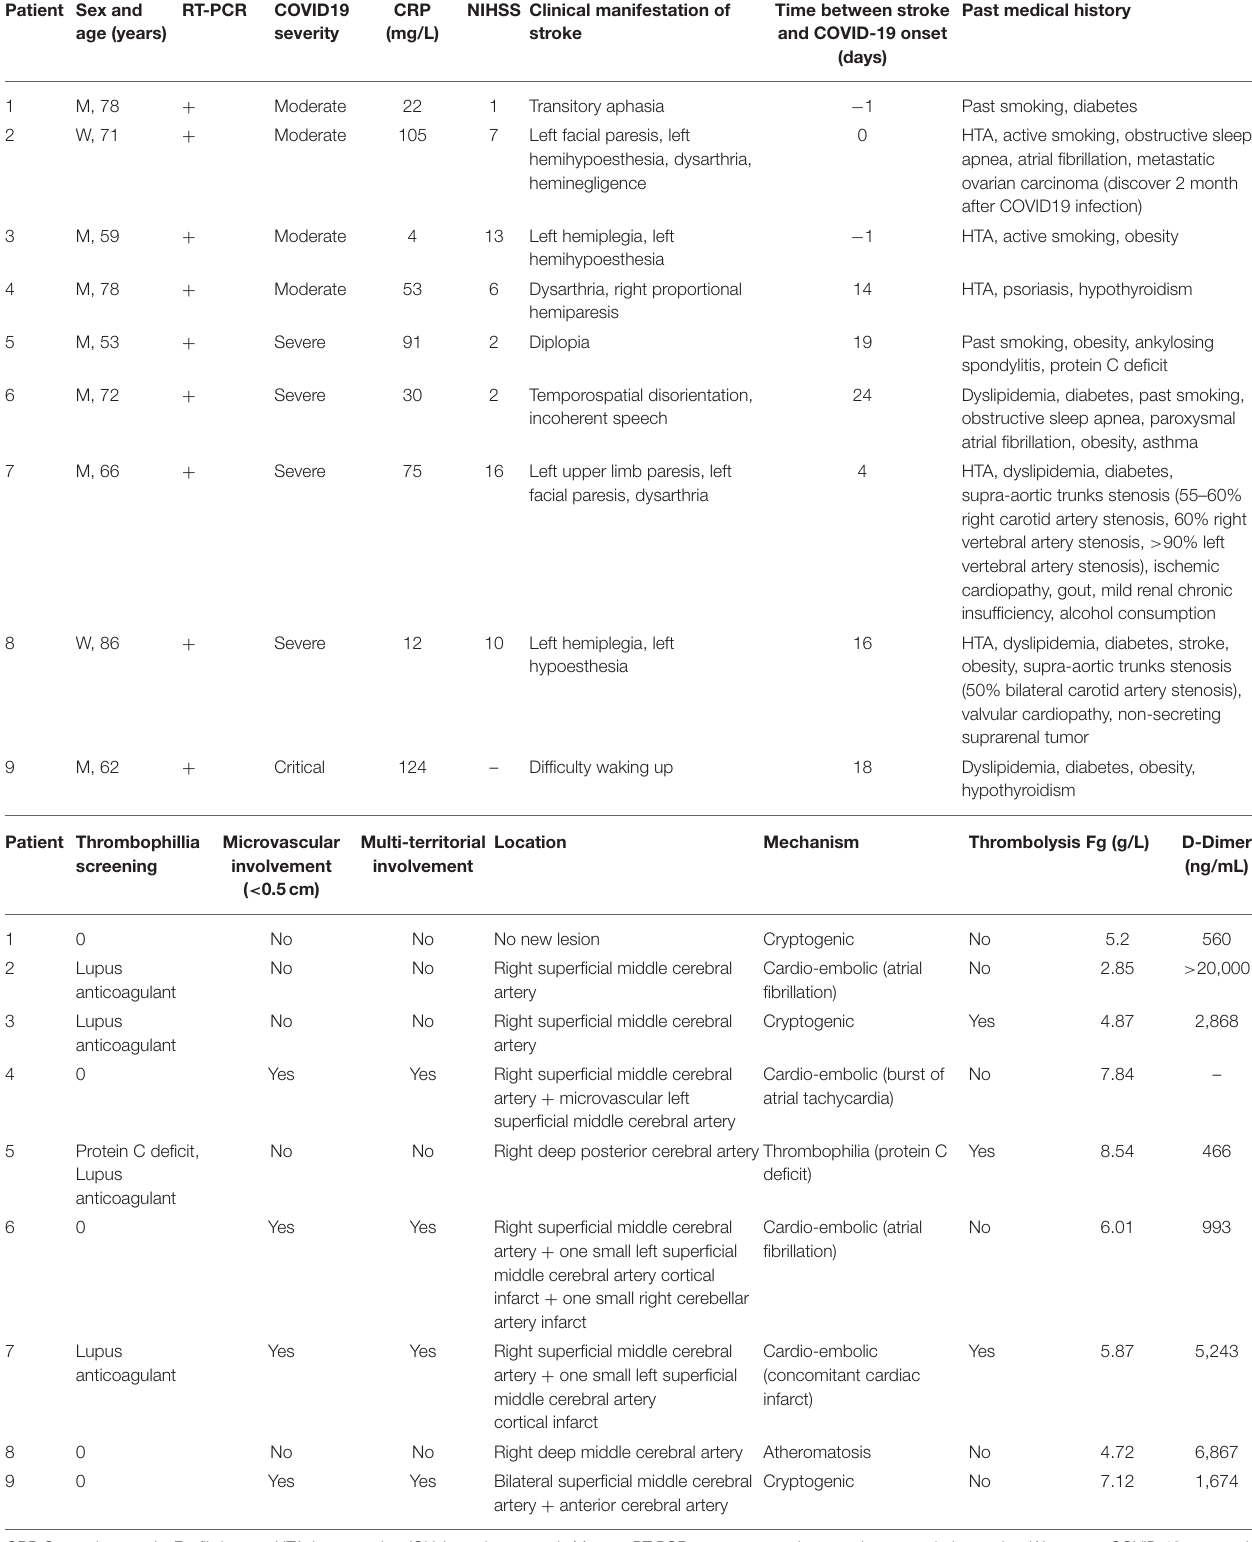
TABLE 1 | Demographic, clinical, biological, and radiological data and mechanism of the nine COVID-19 patients. Patient Sex and age (years)